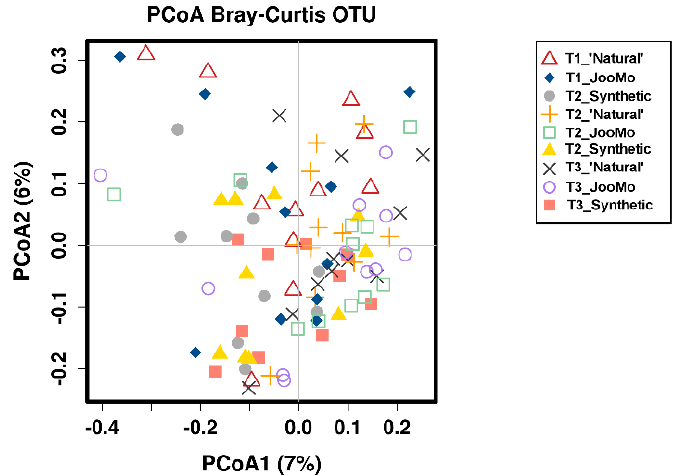
Figure A1. PCoA Plot of the different time points per group. Each point refers to one microbiome measurement. Shapes and colors indicate the different time points and the product group (see legend). Red framed T1 points seem to move towards the rest during product use.